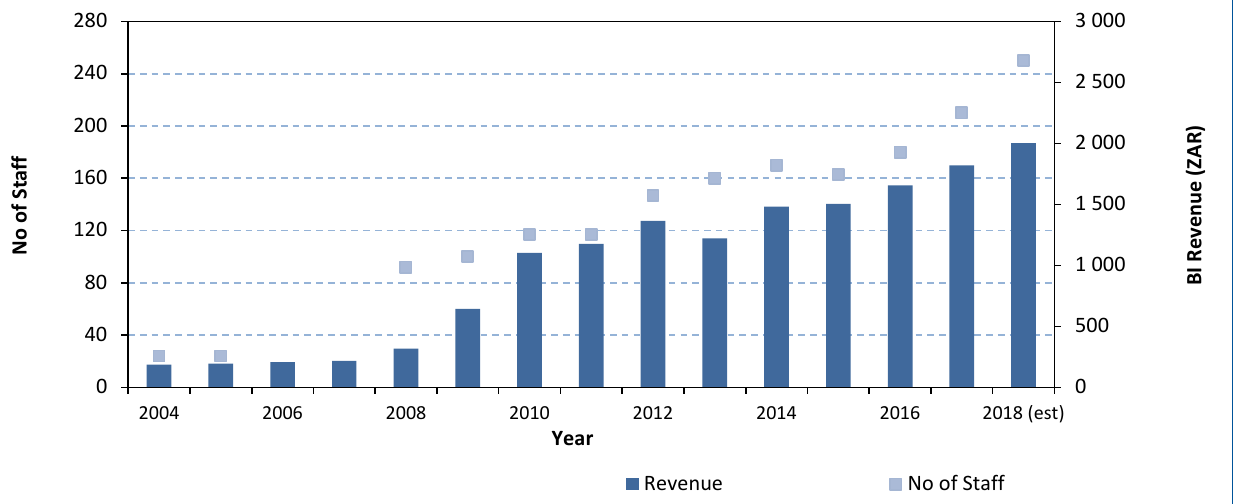
Figure 2. Growth of the Biovac Institute (2004 to